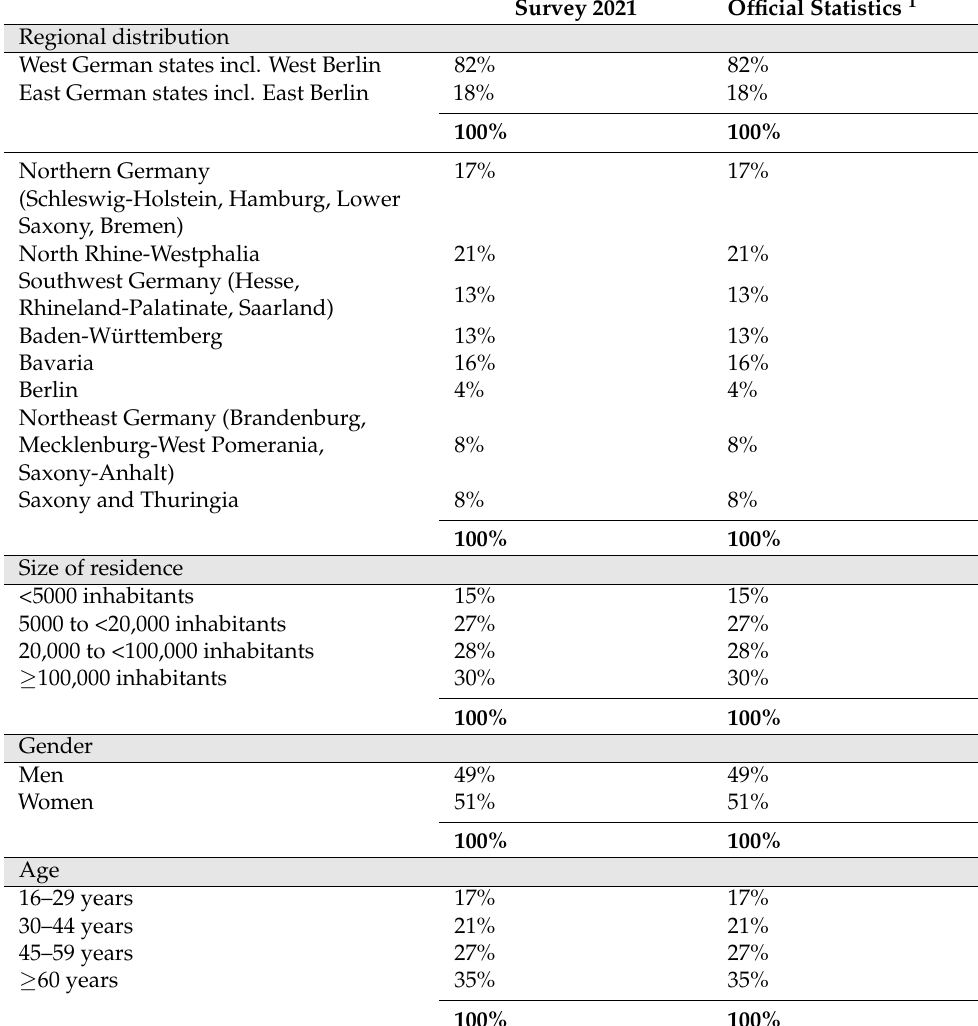
Table A3. Characteristics of the German population according to the official statistics compared to the statistics of the survey in 2021, demonstrating that the survey in 2021 can be assumed to be representative for the German